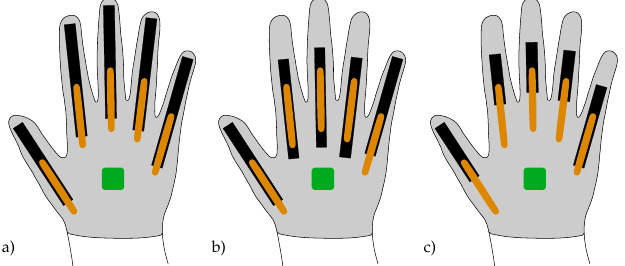
Figure A2. Position variants of the flex sensors (black), depending on the size of the user’s hand in dorsal view. Additional elements shown: mechanical support structure (grey), inertial measurement unit (green), bending sensors for the flexion of the Metacarpophalangeal joint (orange). ( a ) Variant for small-sized hands ( b ) Variant for medium-sized hands ( c ) Variant for large-sized hands